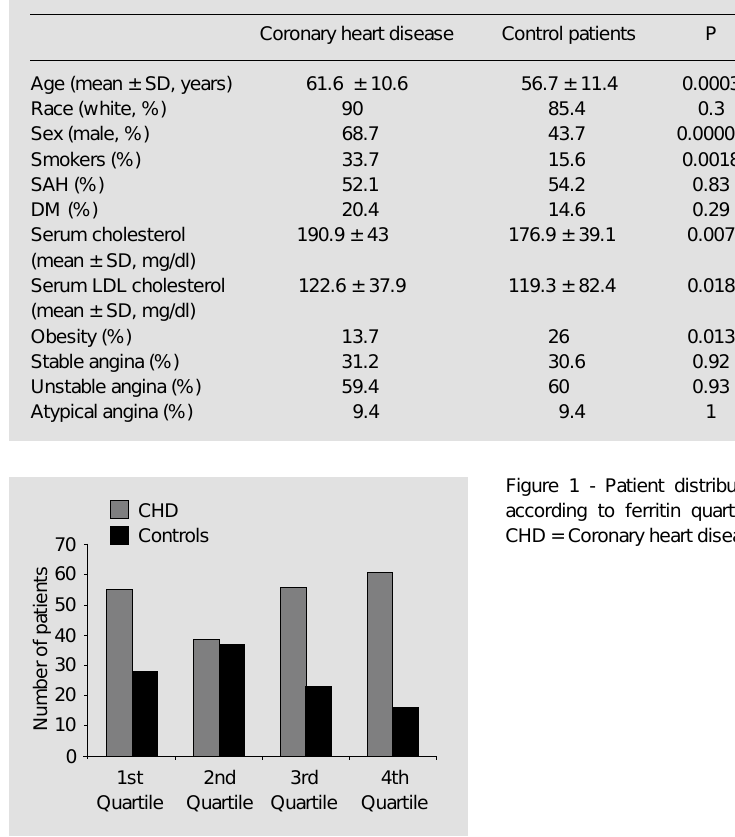
Table 1 - Sample characteristics.